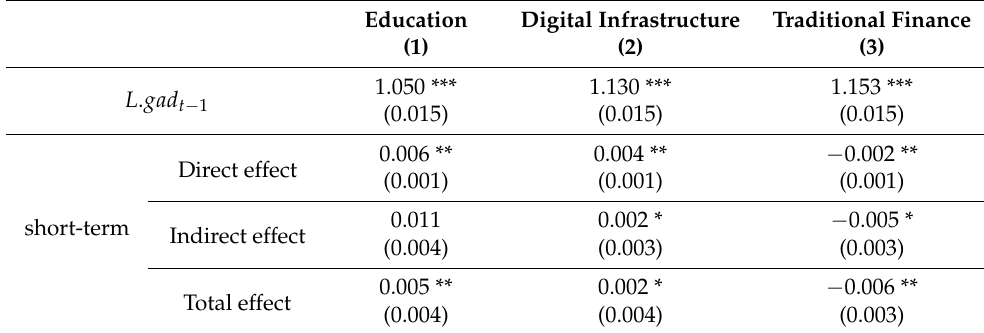
Table 8. Robustness test results of the moderating effect